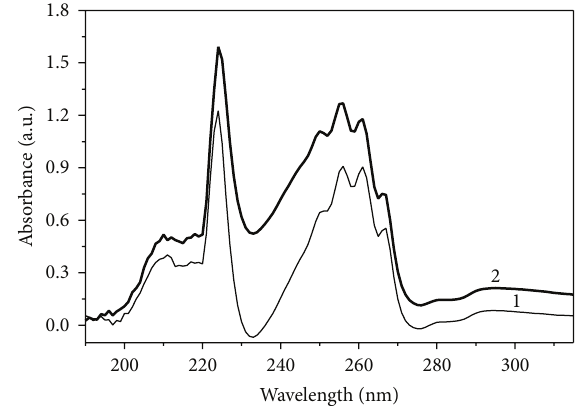
Figure 15: UV spectra of (2 × 10 −3 M) t (3)-methyl- r (2), c (6)-diphen- ylpiperidin-4-one (02) used as inhibitors for mild steel corrosion in 1N H 2 SO 4 solutions [1] before and [2] after weight loss measure- ments.